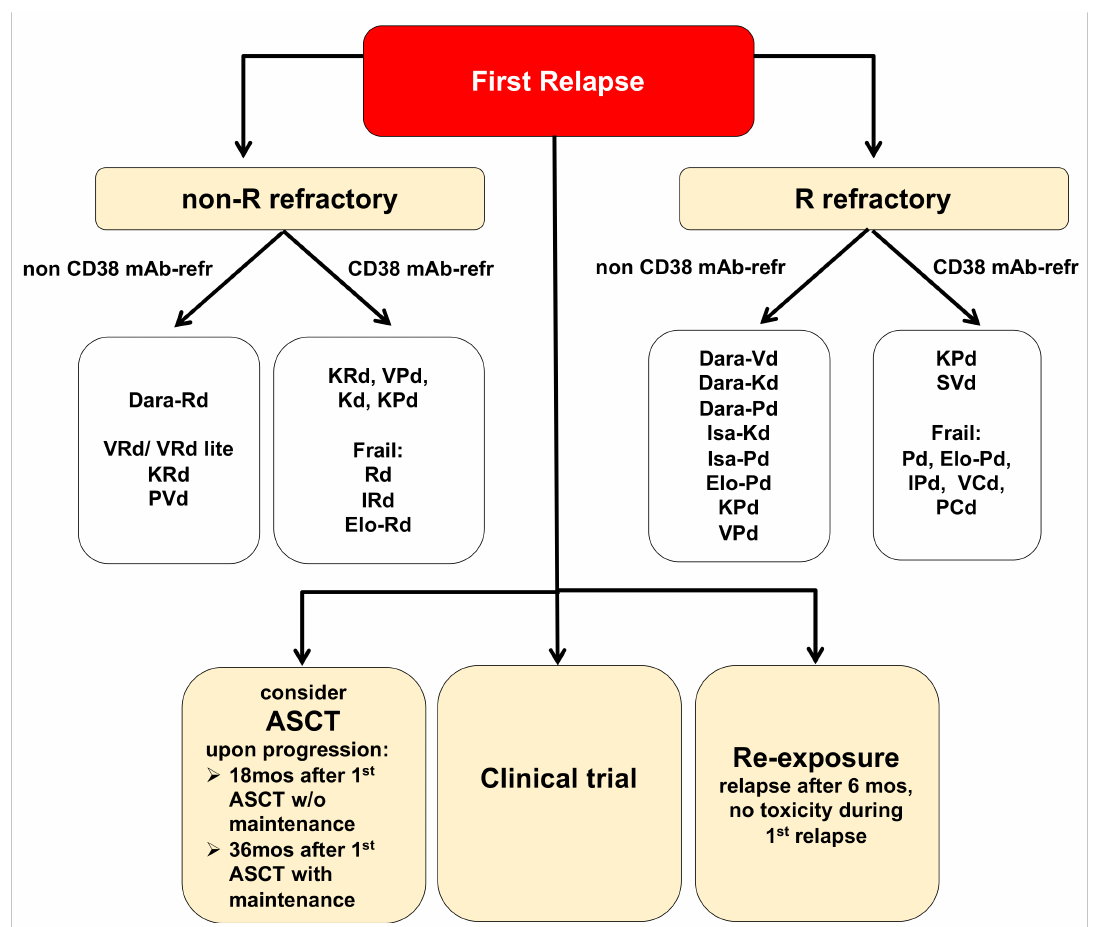
Figure 1. Treatment options for multiple myeloma (MM) patients at first relapse. Listed treatment options are selected and not inclusive of all available regimens. Evidence for these treatment regimens stems from randomized-controlled trials discussed in this review article. Dara, daratumumab; K, carfilzomib; R, Revlimid/lenalidomide; P, pomalidomide; V, Velcade/bortezomib; I, ixazomib; Elo, elotuzumab; Isa, isatuximab; C, cyclophosphamide; ASCT, autologous stem cell